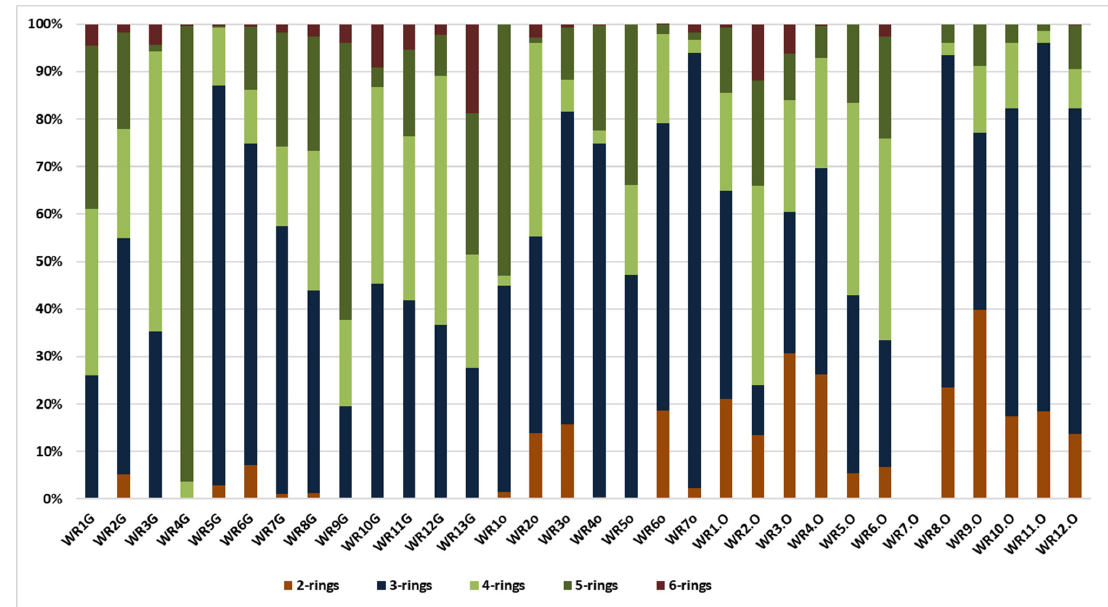
Figure 3. Distribution pattern (%) of 2–6-ring PAHs in the samples (ppm) from Trzebinia.